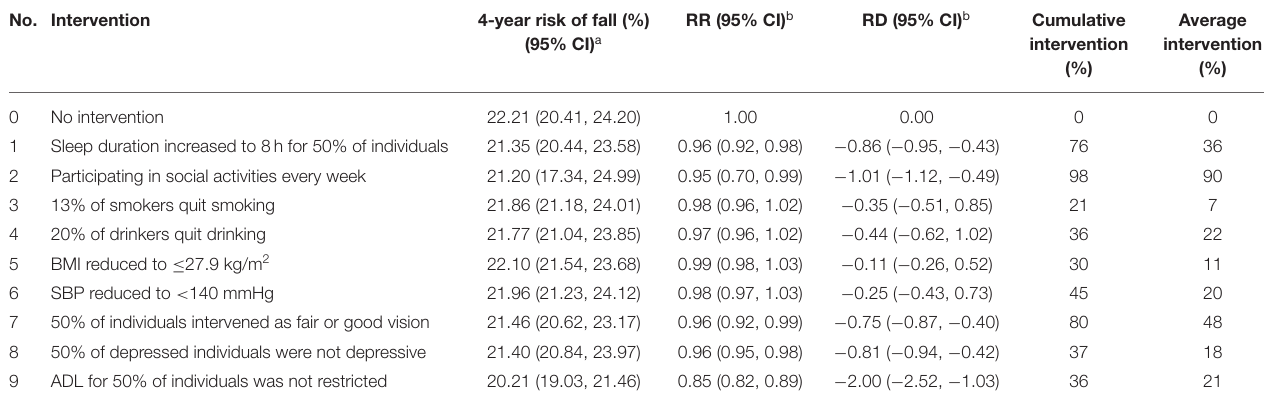
TABLE 3 | Risk of fall under feasible hypothetical interventions (CHARLS 2011–2015). No.